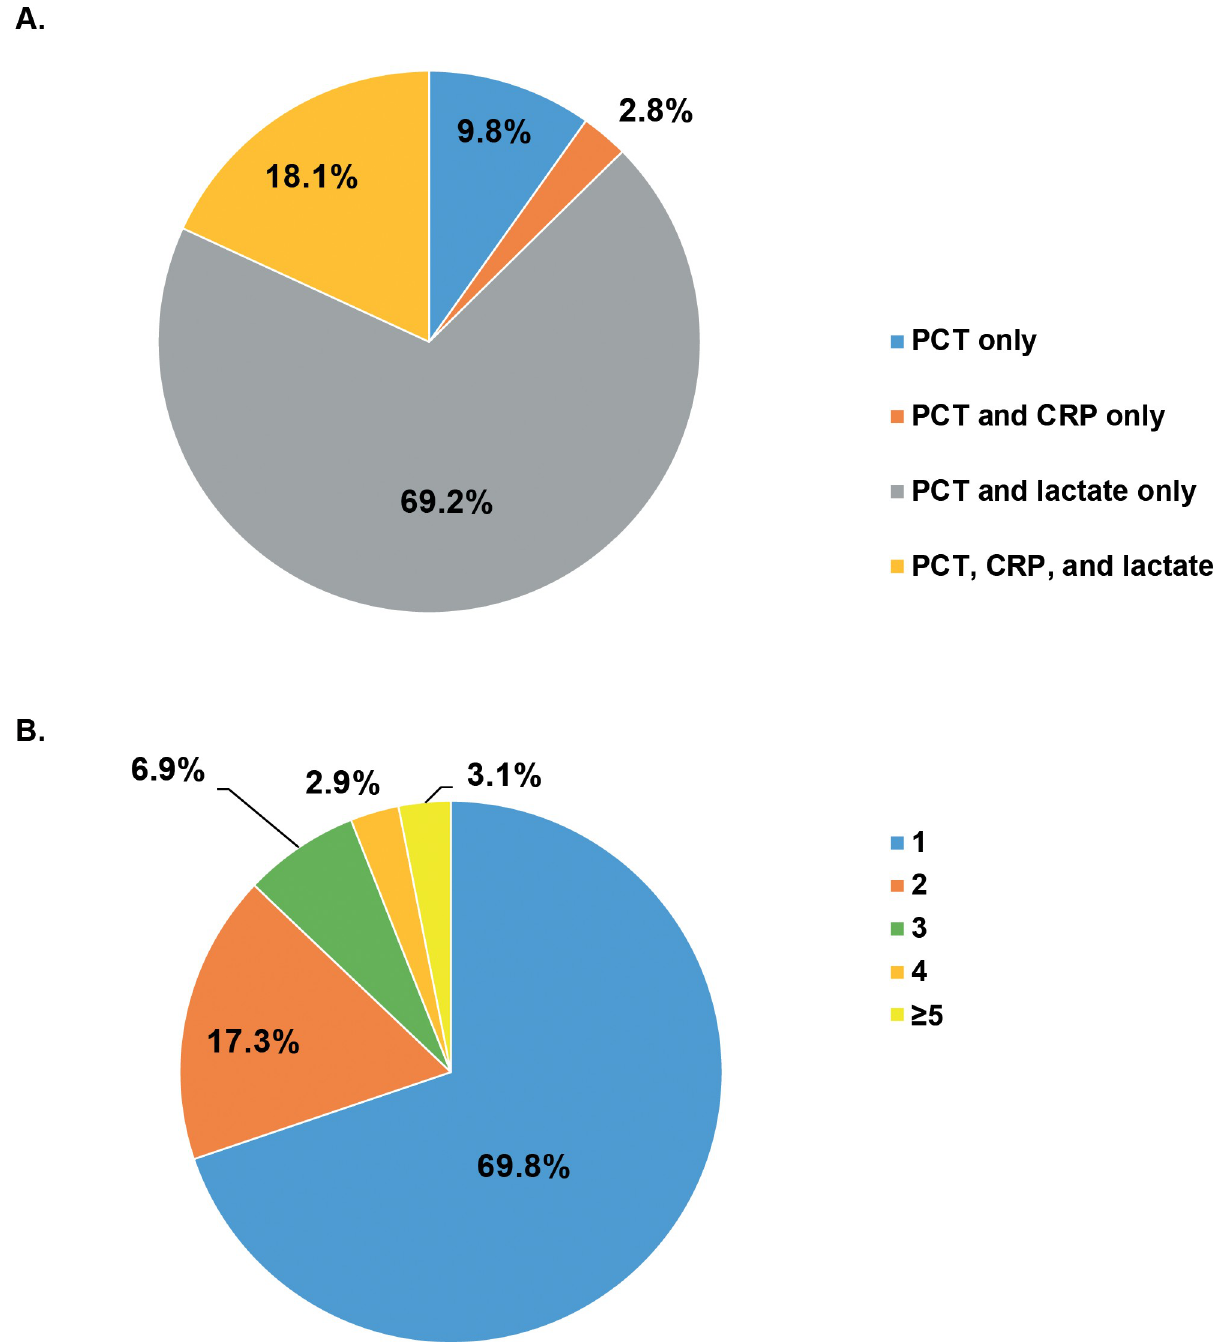
Fig 1. Sepsis biomarker ordering patterns among discharges with � 1 PCT test (N = 113,479). (A) Patterns of sepsis biomarker orders. (B) Frequency of PCT test orders. CRP, C-reactive protein; PCT, procalcitonin.